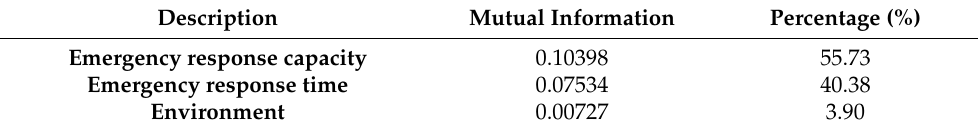
Table 3. Mutual information between ship pollution emergency response result and parent